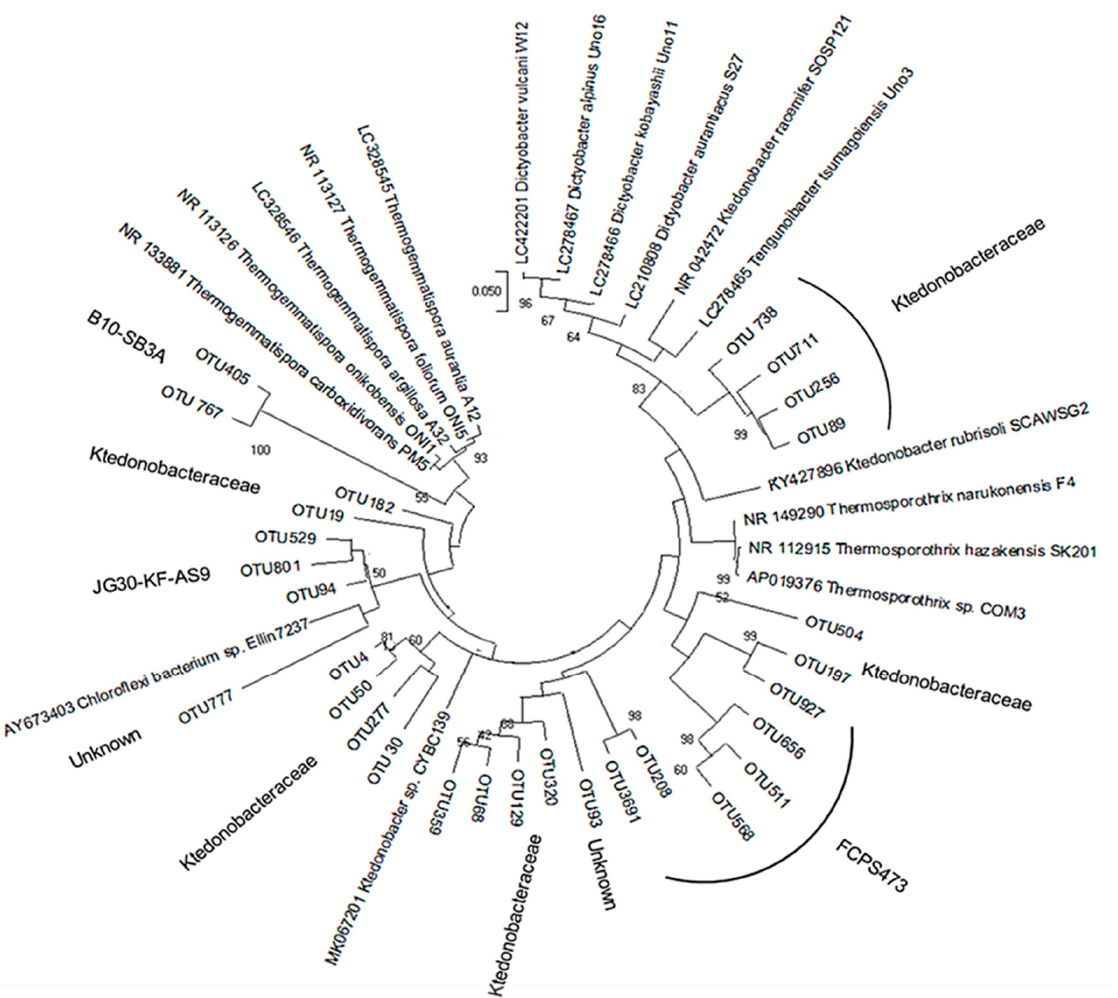
Figure 4. Maximum likelihood phylogenetic tree including Ktedonobacteria OTUs. The phylogenetic tree was constructed by aligning OTU sequences potentially affiliated with Ktedonobacteria with 16S rRNA gene sequences of known Ktedonobacteria species.